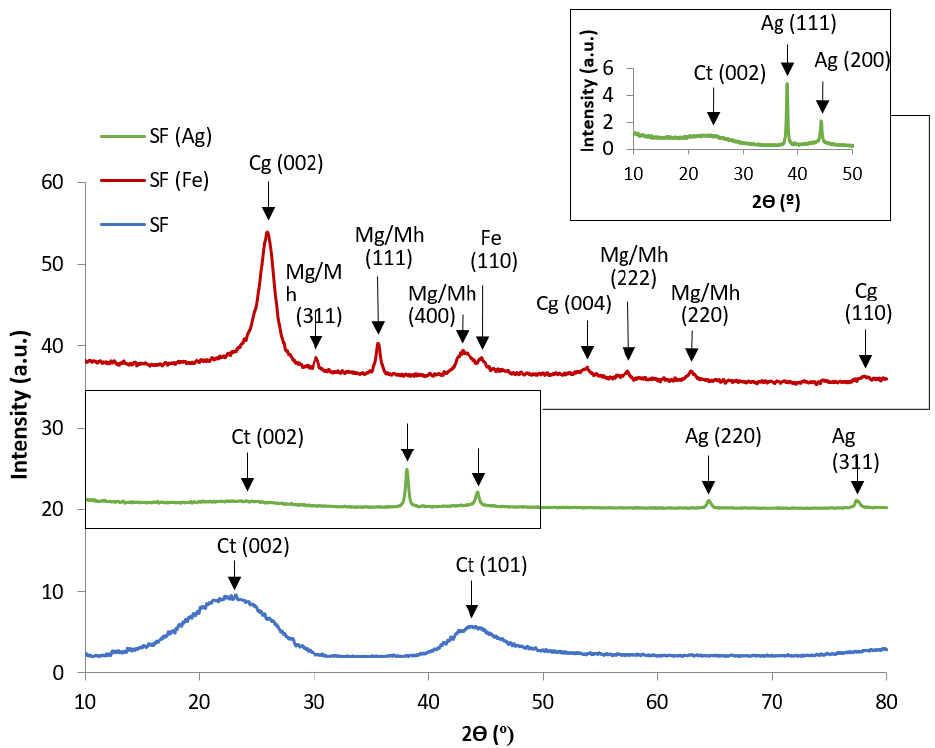
Figure 8. XRD patterns of the carbon foams SF(Fe) and SF(Ag) compared with SF. Cg: graphitic structure; Ct: turbostratic graphite structure; Mg/Mh: magnetite/maghemite; Fe: elemental iron. Inset plot: magnification of the lowest part of SF(Ag) XRD pattern.